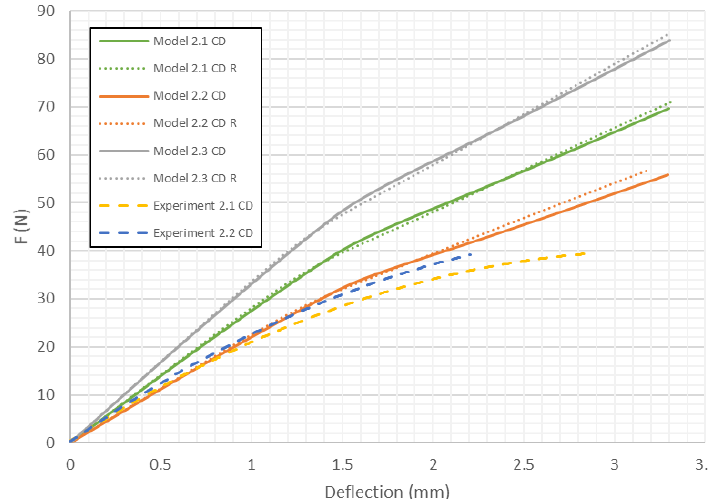
Figure 11. Deflection vs. force for Model 2 in CD.